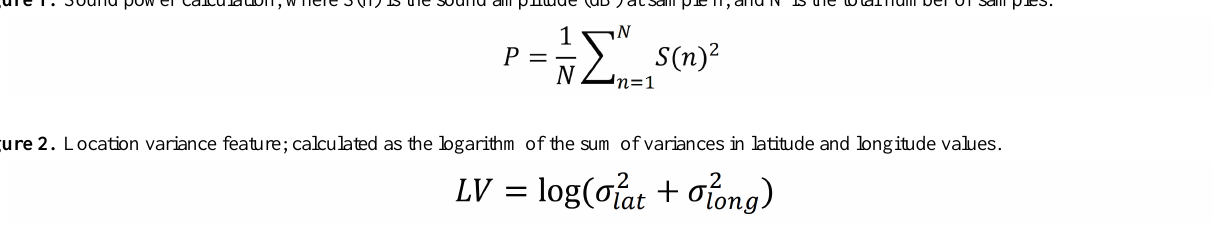
Figure 1. Sound power calculation; where S(n) is the sound amplitude (dB) at sample n, and N is the total number of samples.